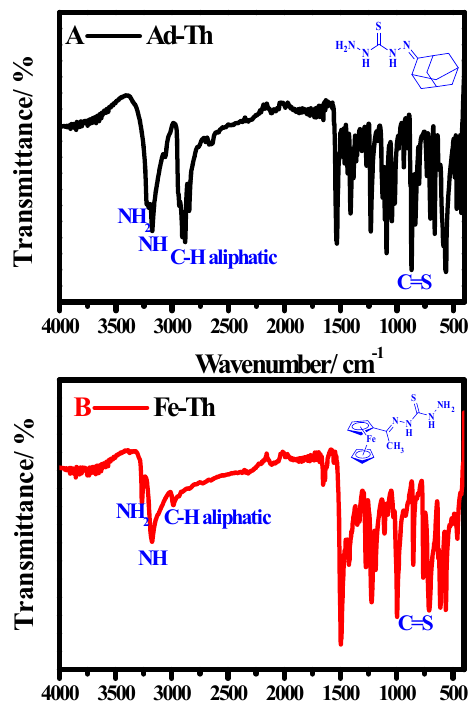
Figure 1. FTIR spectra of the as-prepared ( A ) Ad-Th and ( B ) Fe-Th compounds.